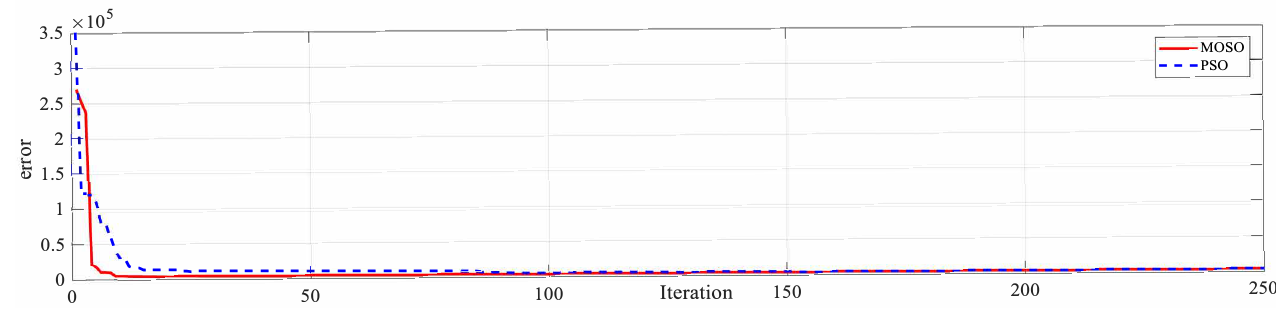
Figure 9. Convergence curve.